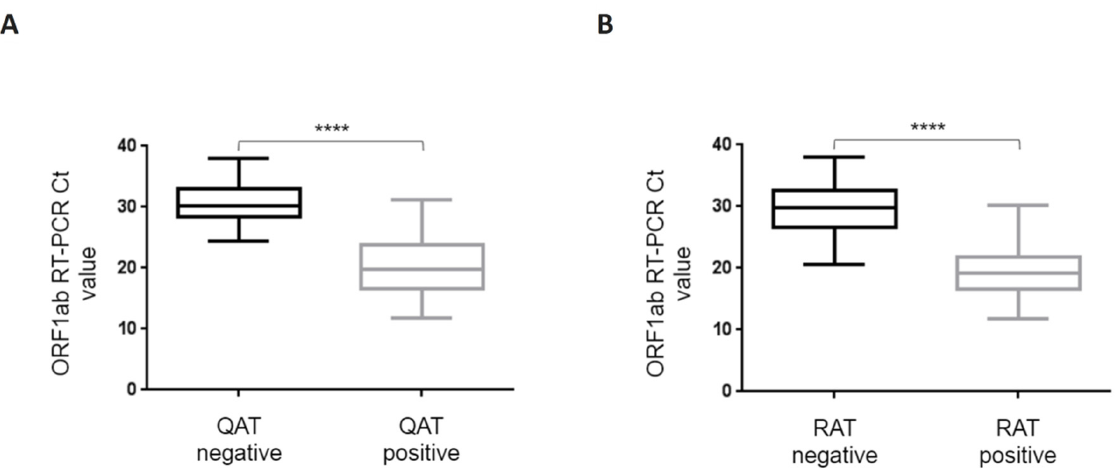
Figure 2. Box-and-whisker plots for ORF1ab RT-PCR Ct values depending on qualitative QAT ( A ) and RAT ( B ) results. ORF1ab RT-PCR Ct value is represented on the ordinate. QAT ( A ) and RAT ( B ) results are divided in two groups, positive (including equivocal) and negative. P value of the difference is represented on the graph as “****” for p < 0.0001. Boxes and whiskers show IQR and range of values (down to the smallest and up to the largest), respectively. Ct: crossing threshold; IQR: interquartile range; QAT: quantitative antigen test; RAT: rapid antigen test.